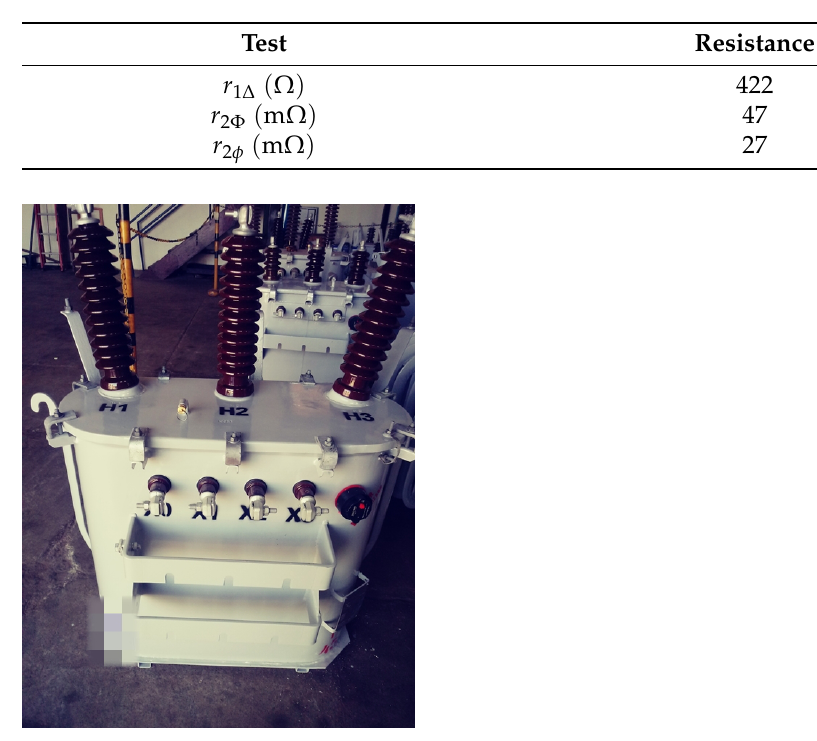
Figure 7. Picture of the transformer considered in the experiment. A comparison between the obtained resistance parameter values and those yielded using solely short and open circuit tests to compute the standard transformer model is given in Table 3. The error function E ( δ ) is plotted in Figure 8 for the multiple values o of δ o , among which the selected value δ o = δ ∈ I where the symbol designates floor rounding to the third decimal place. Finally, Figure 9 (cid:98)·(cid:99) corresponds to the plots of solution pairs ( r 1 , r 1 b ) corresponding to each δ o , with that associated with the selected δ o = 0.012 also being highlighted. Total computation time associated with the brute-force search in domains Table 3. Computed power transformer model